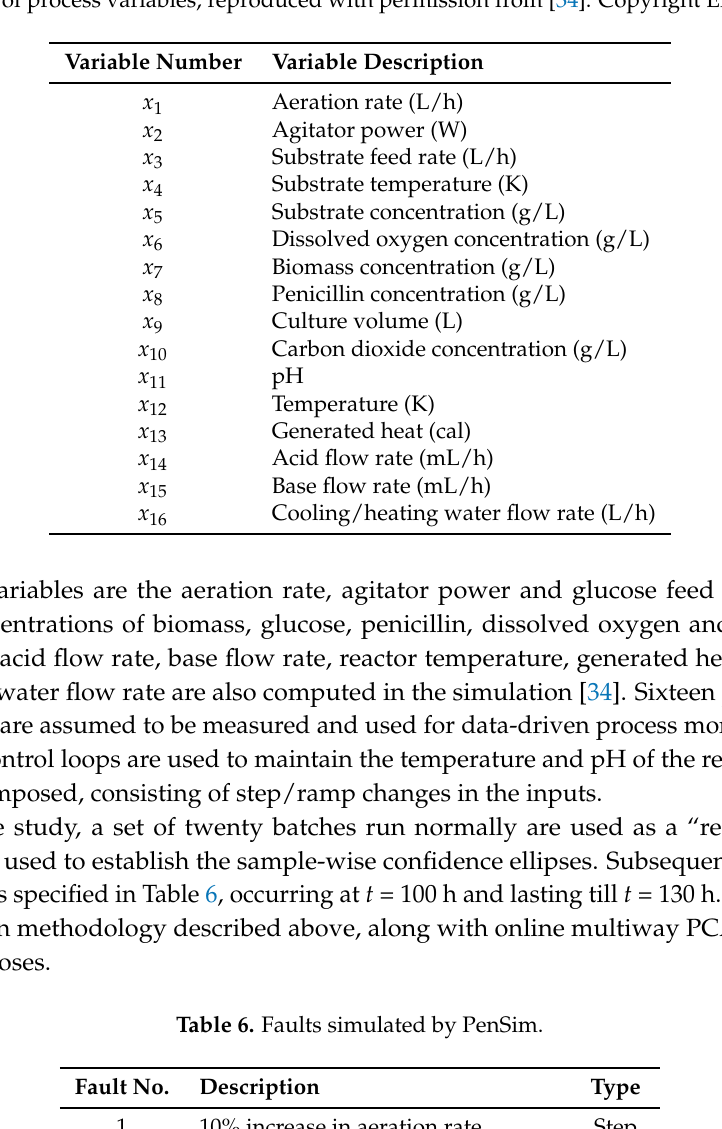
Table 5. List of process variables, reproduced with permission from [34]. Copyright Elsevier, 2002.